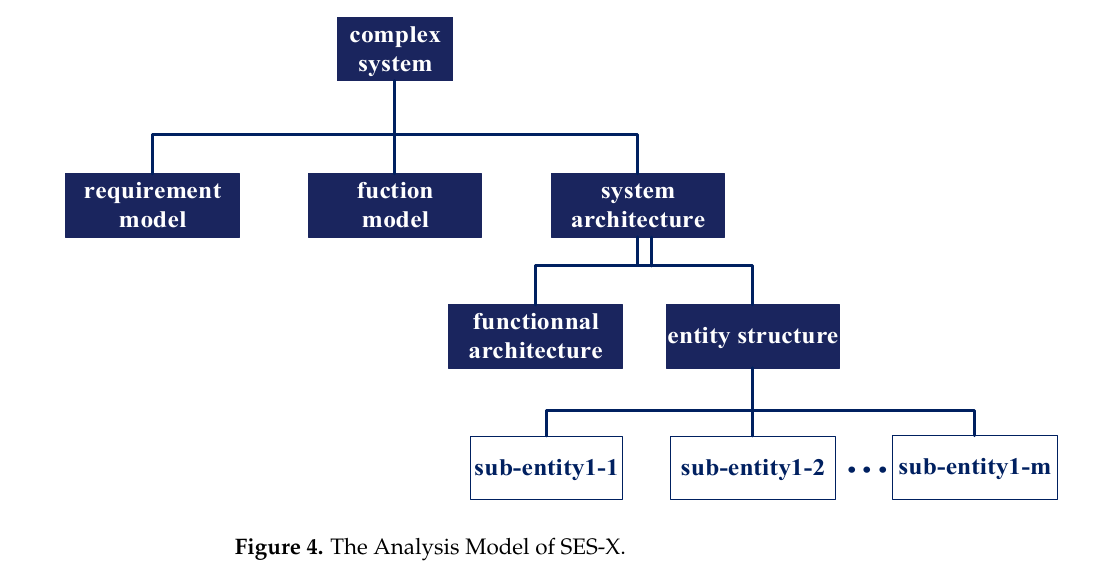
Figure 4. The Analysis Model of SES-X.